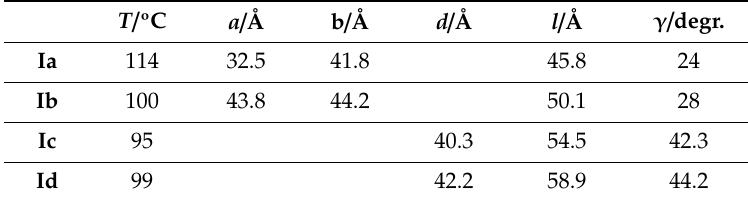
Table 2. Parameters of the crystallographic unit cell, a and b , at selected temperatures, T . For Ic and Id the layer spacing, d , and the calculated length of the molecule, l , and calculated value of the tilt angle, γ , are